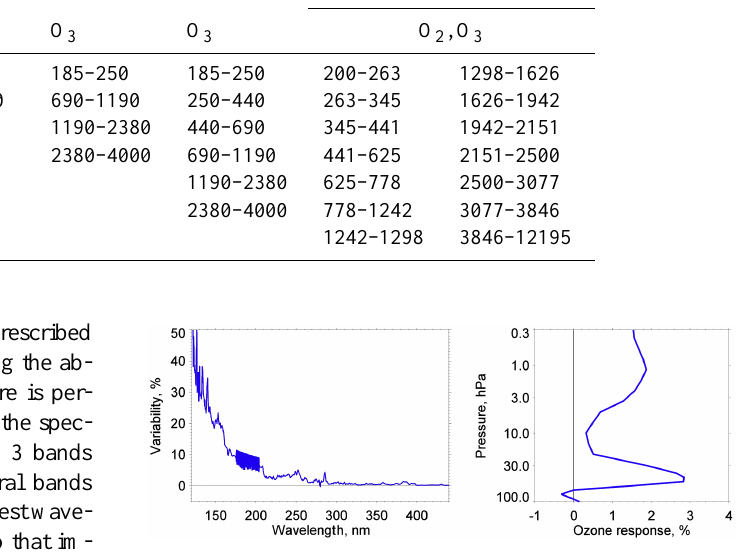
Table 1. ECHAM solar radiation scheme spectral intervals and main absorbers in the UV part of spectrum. Scheme E4 E5 E5c E6 Main absorbers in the UV O 3 O 3 O 3 O 2 , O 3 Wavelength bands, nm